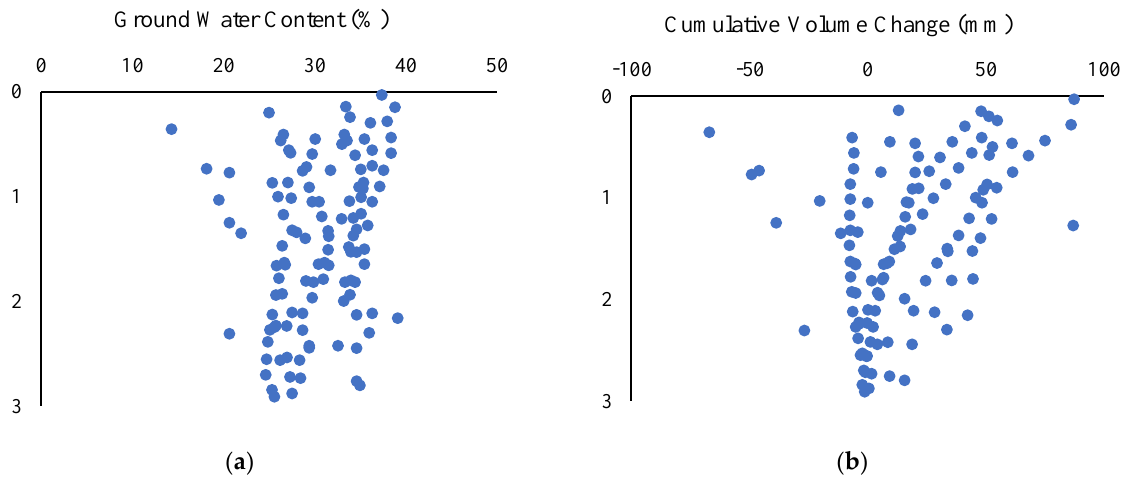
Figure 1. Field data for the investigated expansive clay profile. ( a ) Ground water content, ( b ) cumulative volume change.